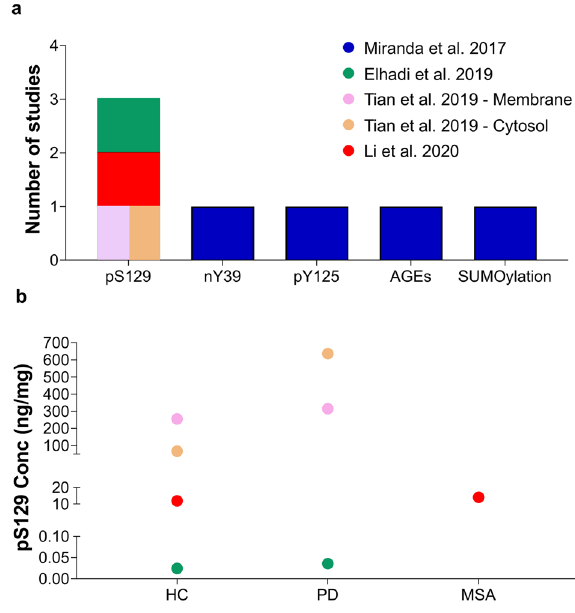
Fig. 6 aSyn PTMs in RBCs. a Number of studies that reported the identi fi cation of different aSyn PTMs in RBCs. b Variability of pS129 levels across the different studies comparing PD to HC or to patients with other synucleinopathies such as MSA. In this graph, it is also depicted that RBC pS129 levels differ between the membrane and cytosol fractions 149 . Each dot represents the mean levels of pS129 aSyn reported in each study. The levels of aSyn PTMs such as nY39, pY125, AGEs or SUMOylation are not depicted in the fi gure because they were assessed only by dot and Western blotting analysis 146 ; no assay for obtaining an “ absolute ” quanti fi cation was carried out. The legend/color code in a corresponds also to b